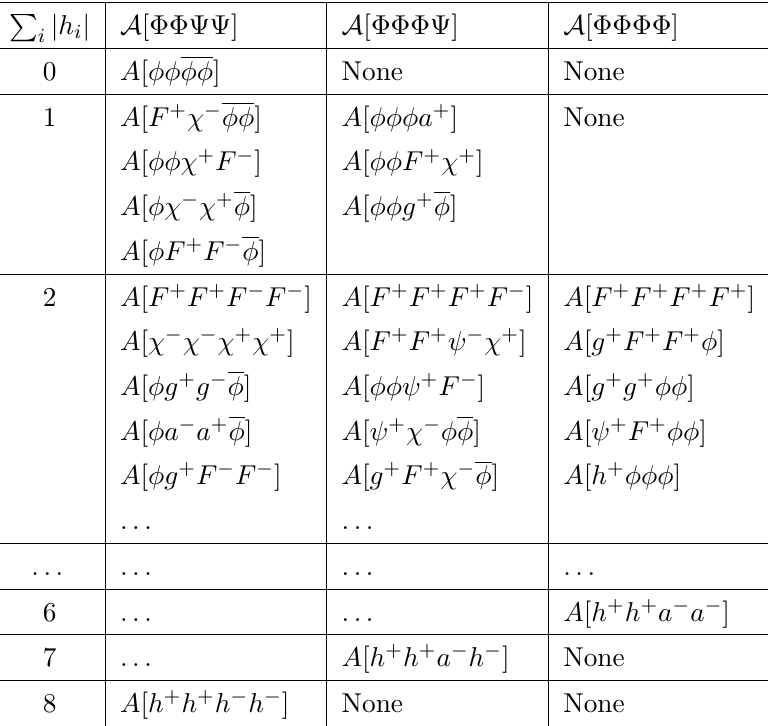
Table 2 . Component amplitudes of each superamplitude, organised by total helicity P h i is the helicity of the i th particle. We have not included amplitudes equivalent to the ones listed here under